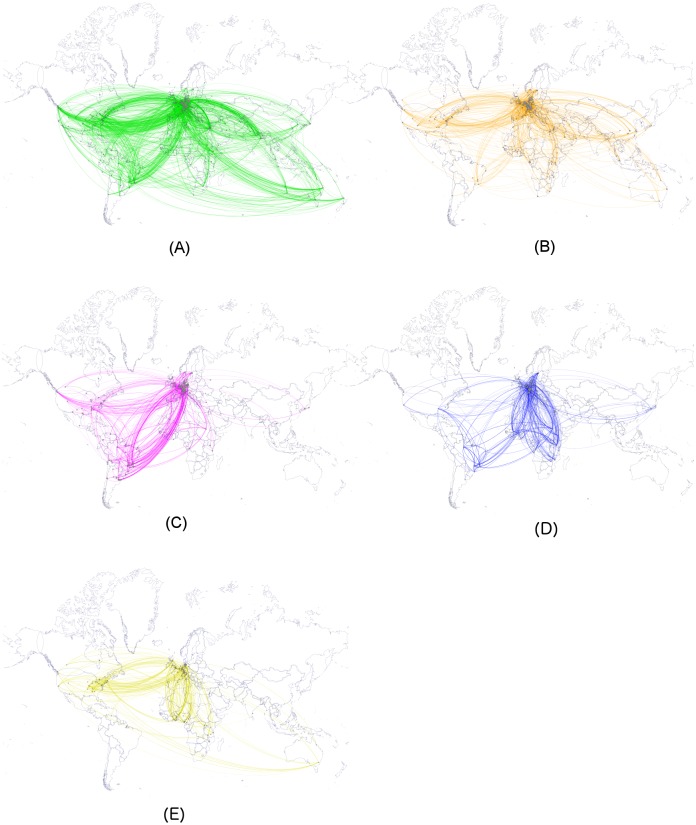
Worldwide connections between German research institutions and partners abroad.Research networks are based on co-author networks affiliated with Germany, i.e., those covering publications with at least one co-author affiliated with a German institution; nodes (circles) indicate research institutions, and edges (colored lines) indicate co-authored publications between authors based at those institutions. The maps show research networks for (A) Leishmaniasis, (B) Schistosomiasis, (C) Chagas disease, (D) Sleeping Sickness and (E) Onchocerciasis.